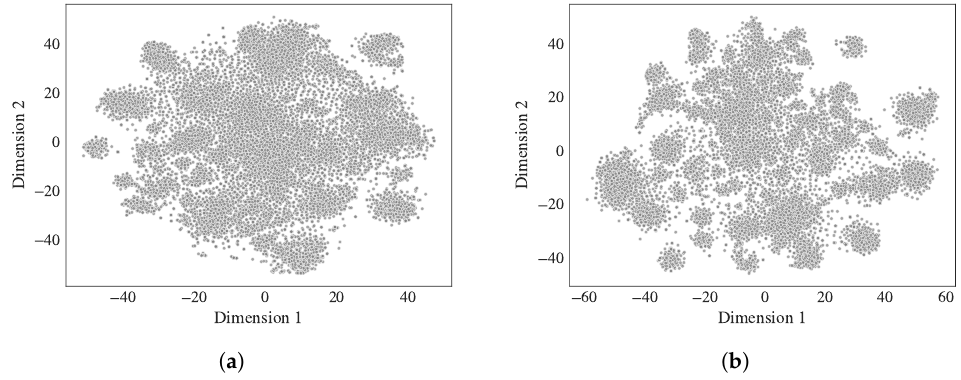
Figure 2. t-Distributed Stochastic Neighbor Embedding (t-SNE) visualization of narratives through Bag-of-Words and TF-IDF models. ( a ) Bag-of-Words Model. ( b ) TF-IDF